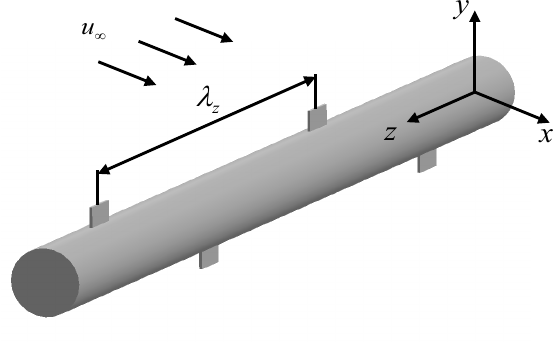
Figure 14. Schematic diagram of a circular cylinder with tabs in a staggered